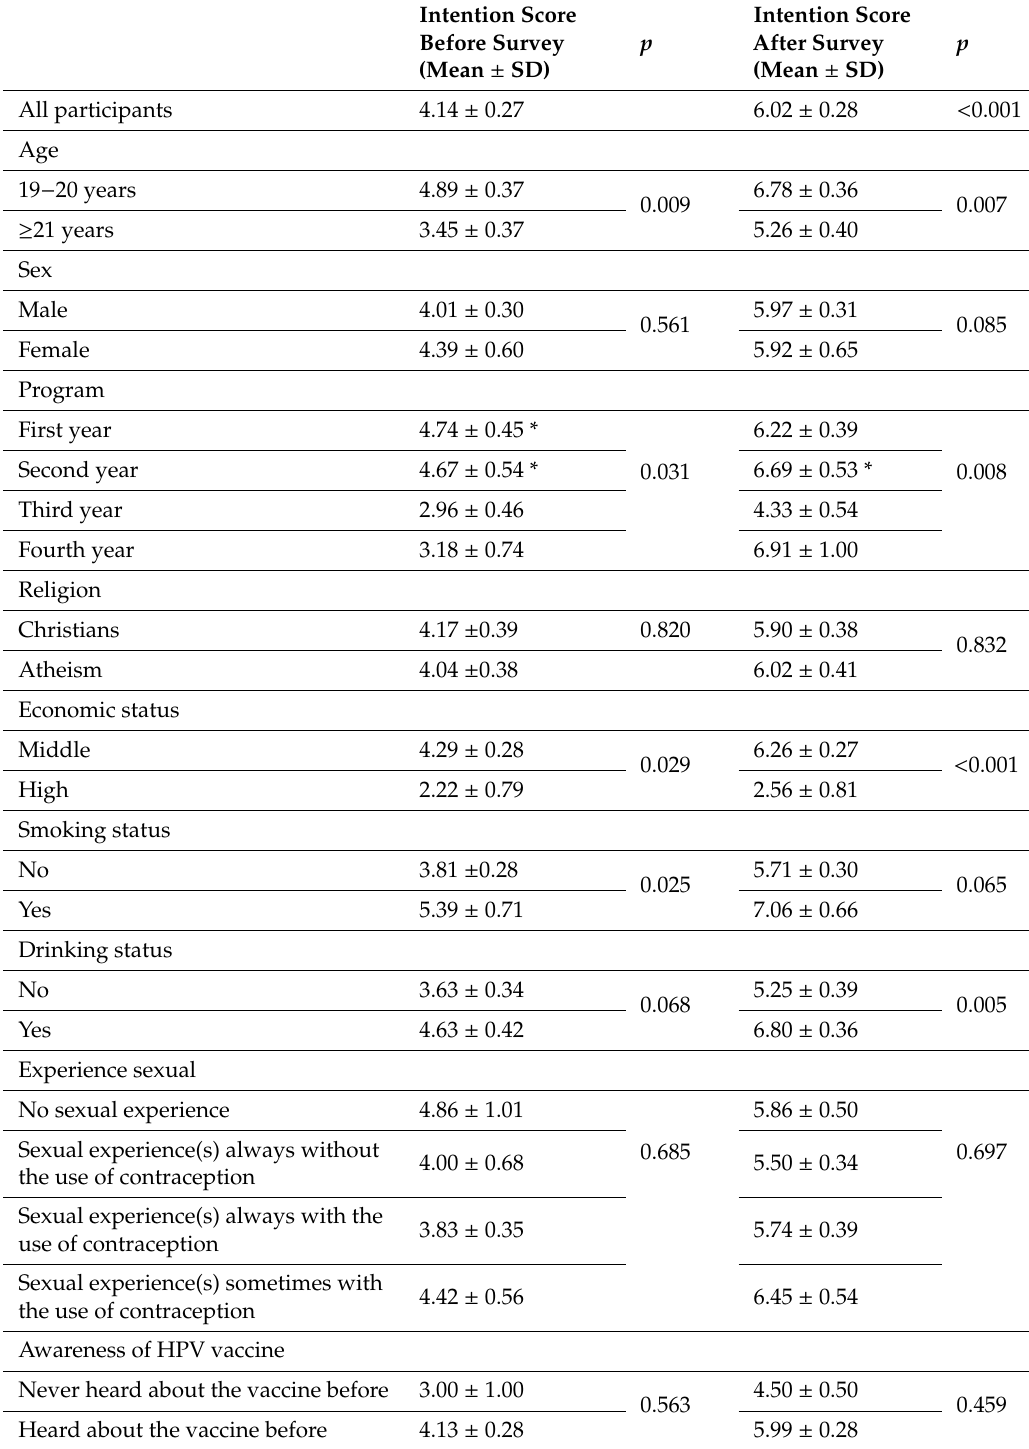
Table 5. Intention score to obtain the HPV vaccine before and after the questionnaire stratified by students’